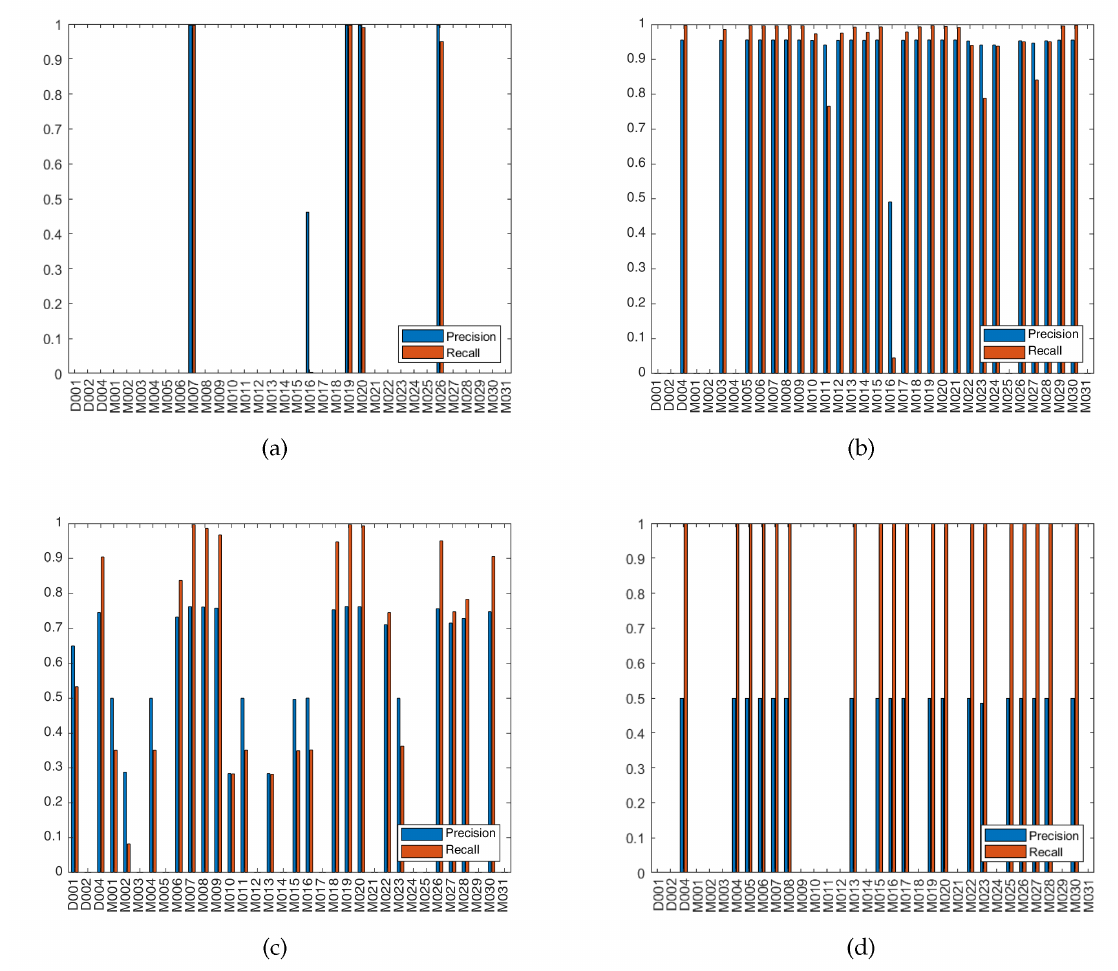
Figure 6. Precision and recall of failure detection when a sensor has fail-stop failure, at health threshold 0.4, ( a ) sliding window 0 s, minimum relative support 45%, and minimum confidence 60%. ( b ) sliding window 60 s, minimum relative support 45%, and minimum confidence 60%. ( c ) sliding window 0 s, minimum relative support 2%, and minimum confidence 60%. ( d ) sliding window 0 s, minimum relative support 45%, and minimum confidence